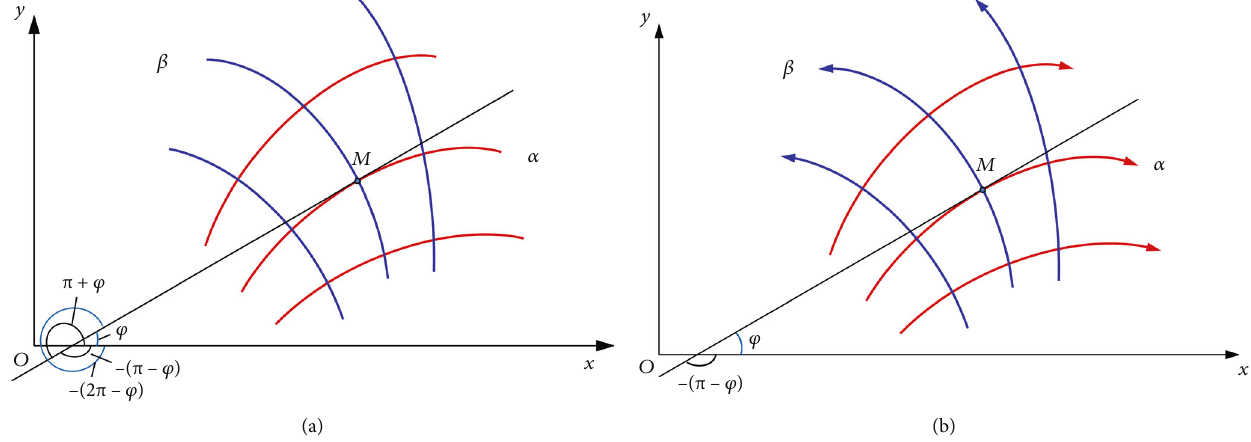
Figure 1: Diagram of slip-line fi eld: (a) with no direction; (b) with clear direction.